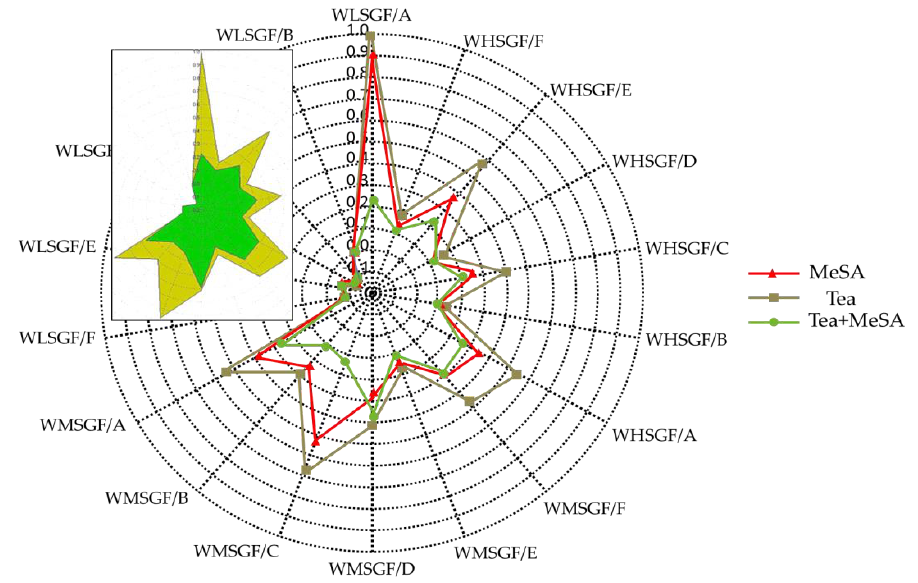
Figure 3. The expression of the interaction of aroma perception on the electronic nose.